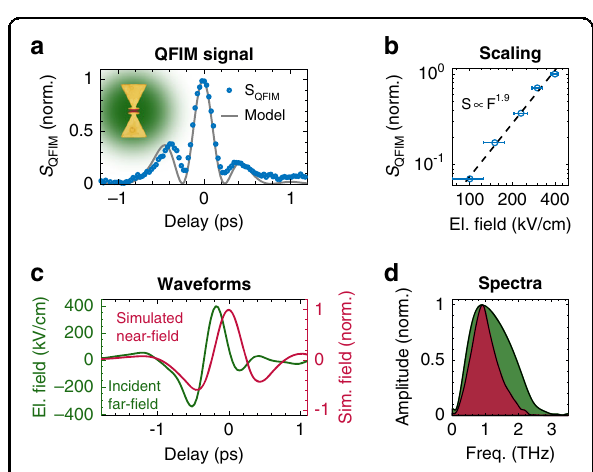
Fig. 3 QFIM signal and near- fi eld waveform inside a bowtie antenna. a Local QFIM signal in the gap of the bowtie (blue circles) and the modeled temporal luminescence evolution (gray) based on the incident waveform. b Scaling of the peak QFIM signal (circles) as a function of the maximum incident fi eld strength. c Comparison of the driving far- fi eld waveform (green) and the simulated local near- fi eld inside the bowtie gap (red). d Corresponding spectra of both waveforms shown in ( c